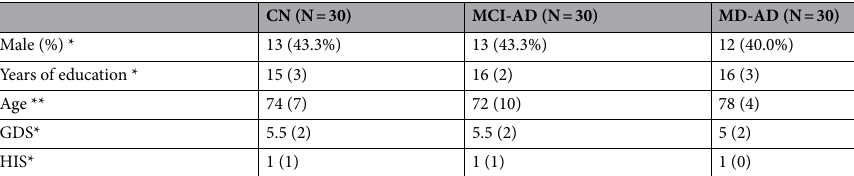
Table 1. Demographic and clinical characteristics of the participants. GDS, Geriatric depression scale; HIS, Hachinski Ischemic Score. Data are represented as median and interquartile range unless specified otherwise. *The groups did not differ significantly. **MD-AD group differed significantly from CN and MCI groups. The CN and MCI groups did not show any significant